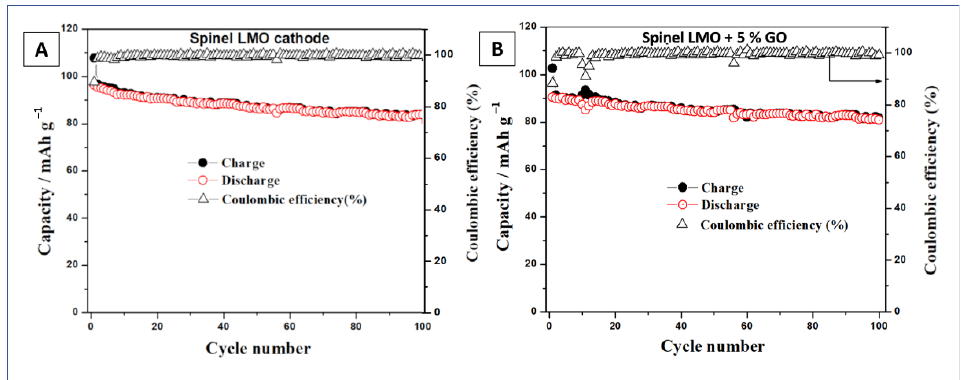
Figure 7. Cyclic performance and coulombic efficiency of LMO ( A ) and LMO + 5%GO; ( B ) spinel electrode for Li-ion battery at the voltage range of 4.3–3.0 V with a current of 20 mA g −1 .